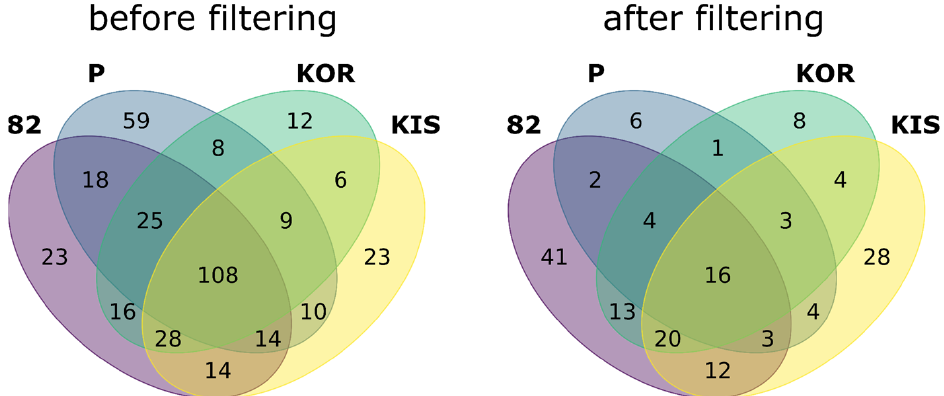
Figure 2. Numbers of peptides with alternative splicing were identified in four melanoma cell lines using the RefSeq database before and after the application of three-step filtering.